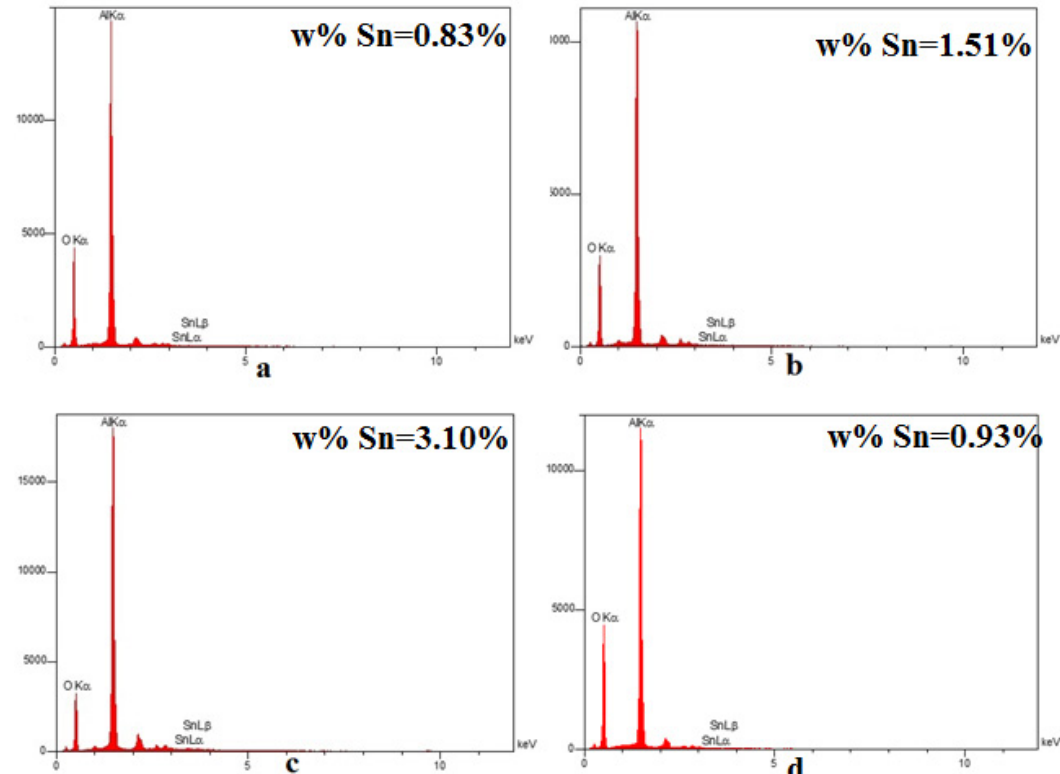
Fig. 3. EDX graph NAA (a) doped Sn during anodization. after hydrothermal process (b) p-type sample with 0.83%W Sn, (c) T-type sample with 1.51%W Sn, (c) w-type sample with 3.10%W